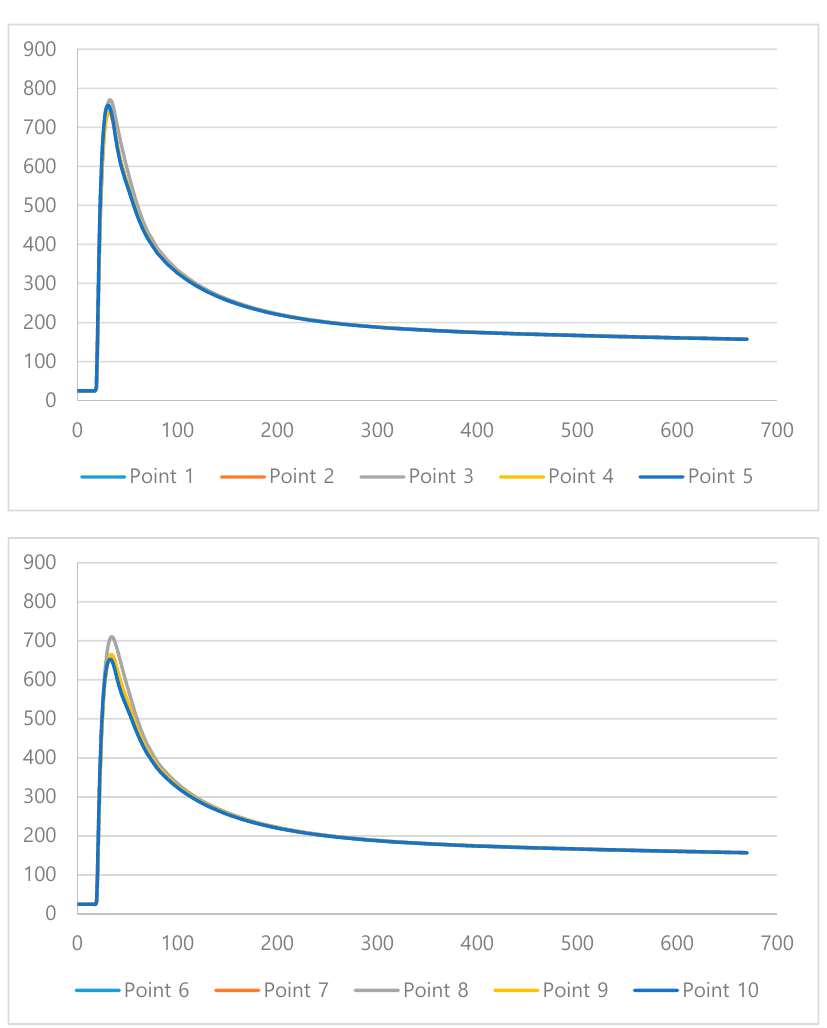
Figure 13. Temperature change over the time on check points. Table 11. Temperature change over the time on check points (°C).